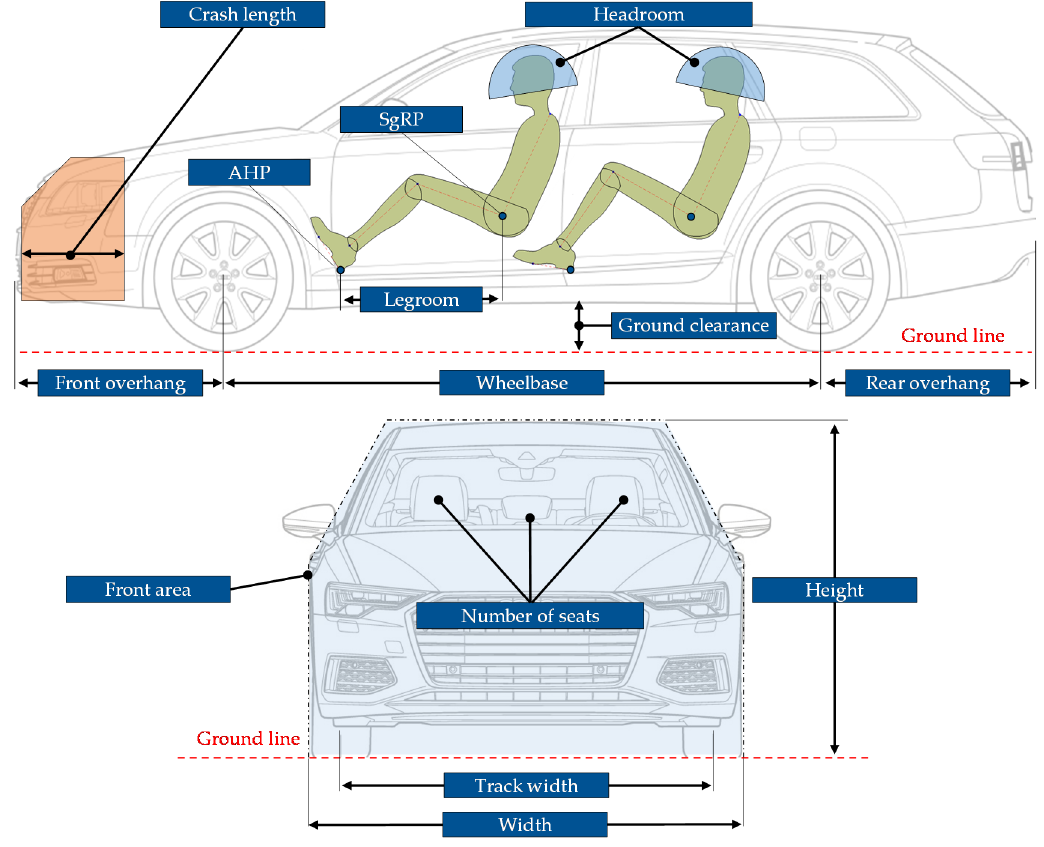
Figure 3. Overview of the design parameters for the dimensional concept, based on [67].